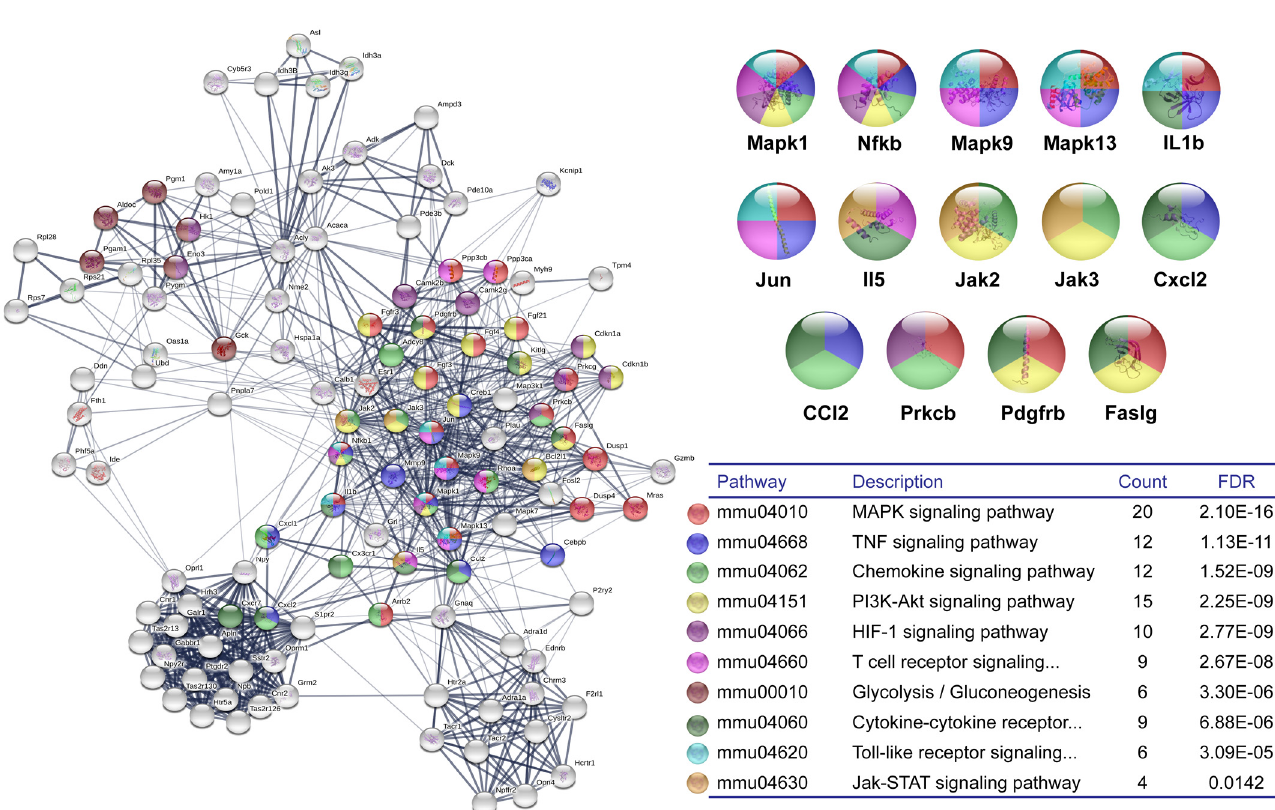
Figure 3. Rheumatoid Arthritis-related signaling pathways at the very early stages of adjuvant-induced arthritis. The genes of clusters 1 and 2 of the times 24 h and 48 h resulting from Cytoscape-MCODE analysis for each comparison were uploaded to the STRING platform to construct the protein interaction network. The KEGG signaling pathways relevant to arthritis were selected (Table) and marked with different colors. Nodes with the most significant interaction in the pathways of interest are amplified. FDR: False discovery rate.